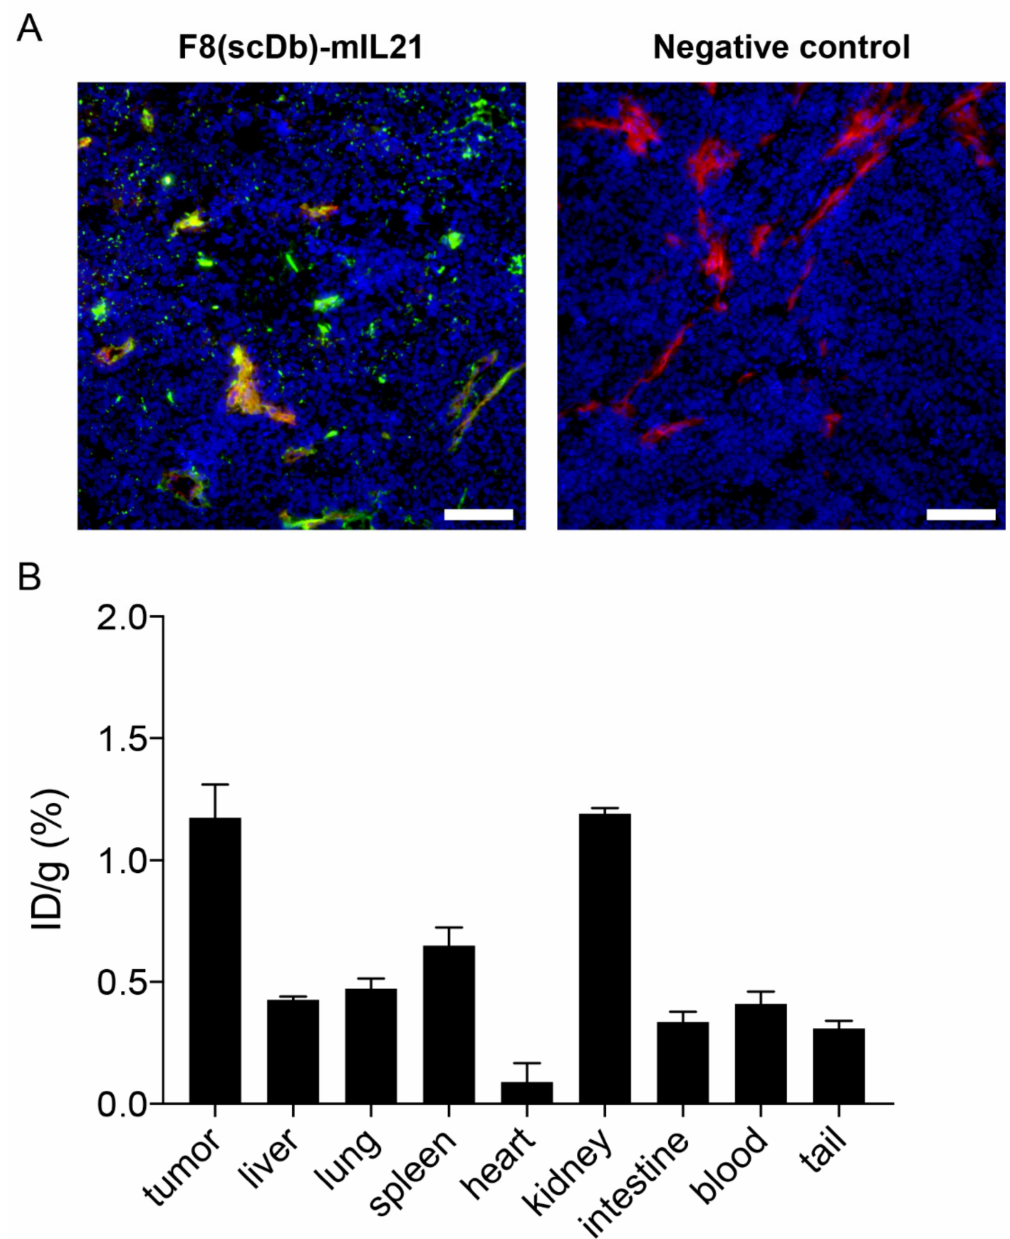
Figure 3. Tumor targeting properties of F8(scDb)-mIL21. ( A ) Microscopic fluorescence evalua- tion of EDA levels on F9 tumor sections detected with F8(scDb)-mIL21 (green, ProteinA Alex- aFluor488). Blood vessels are stained with anti-CD31 (red, AlexaFluor594). Cell nuclei are stained with DAPI (blue). Omission of F8(scDb)-mIL21 was included as negative control, 20 × magnification, scale bars = 100 µ m. ( B ) Quantitative biodistribution analysis. of F8(scDb)-mIL21 was labelled with 125 I and injected into the lateral tail vein of F9 tumor-bearing 129/sv mice. After 1 day, mice were euthanized, organs, blood and tumors were removed, weighed, and radioactivity detected. Plots are expressed as the percentage of the injected dose per gram tissue (%ID/g SEM). Data were adjusted for tumor